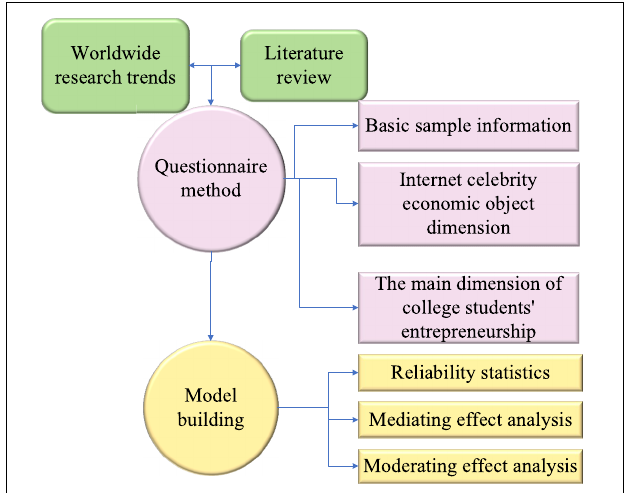
FIGURE 1 | Research methods.